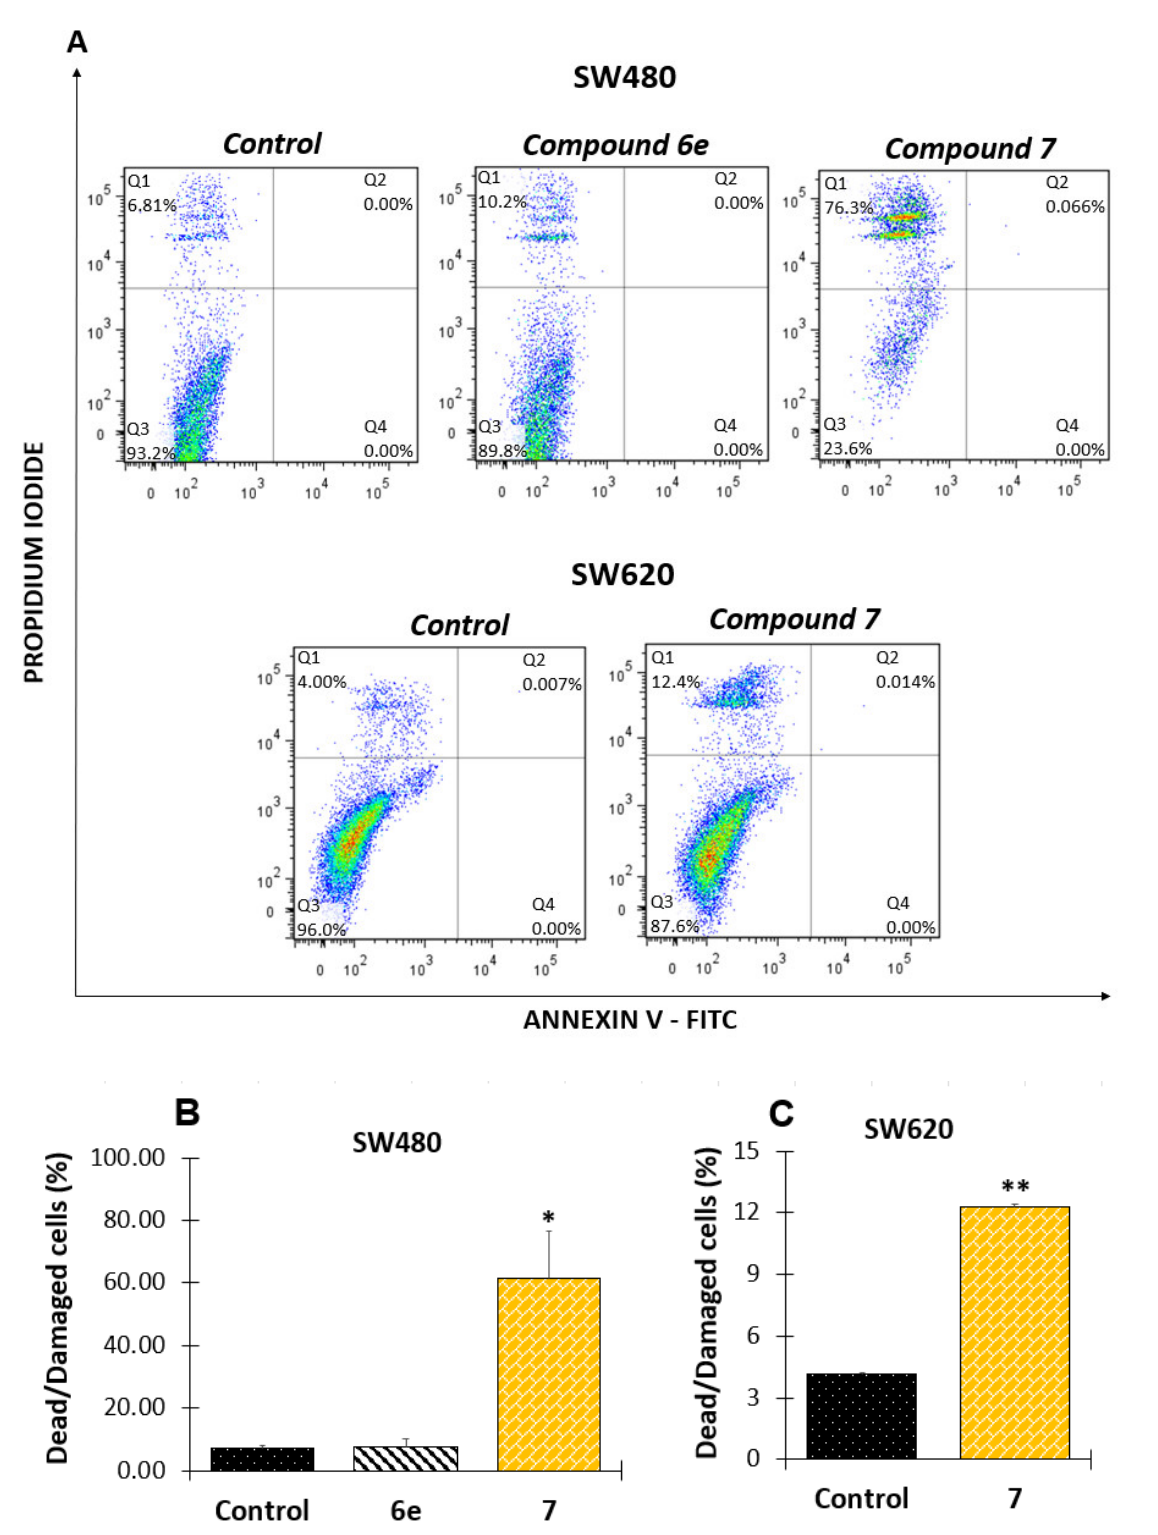
Figure 7. Flow cytometry analysis of apoptosis. ( A ) Representative histograms of SW480 and SW620 cells. Representation of data in bar chart form of ( B ) SW480 cells and ( C ) SW620 cells. Q1 + Q2: Cells which lost membrane integrity (Late apoptotic cells, dead cells, necroptotic cells, secondary necrotic cells, others); Q3: Viable cells; Q4: Early apoptotic cells. Control cells were treated with DMSO (1%). All experiments were performed in duplicate and gave similar results. p values lower than 0.05 were considered statistically significant (* p < 0.05; ** p < 0.01)